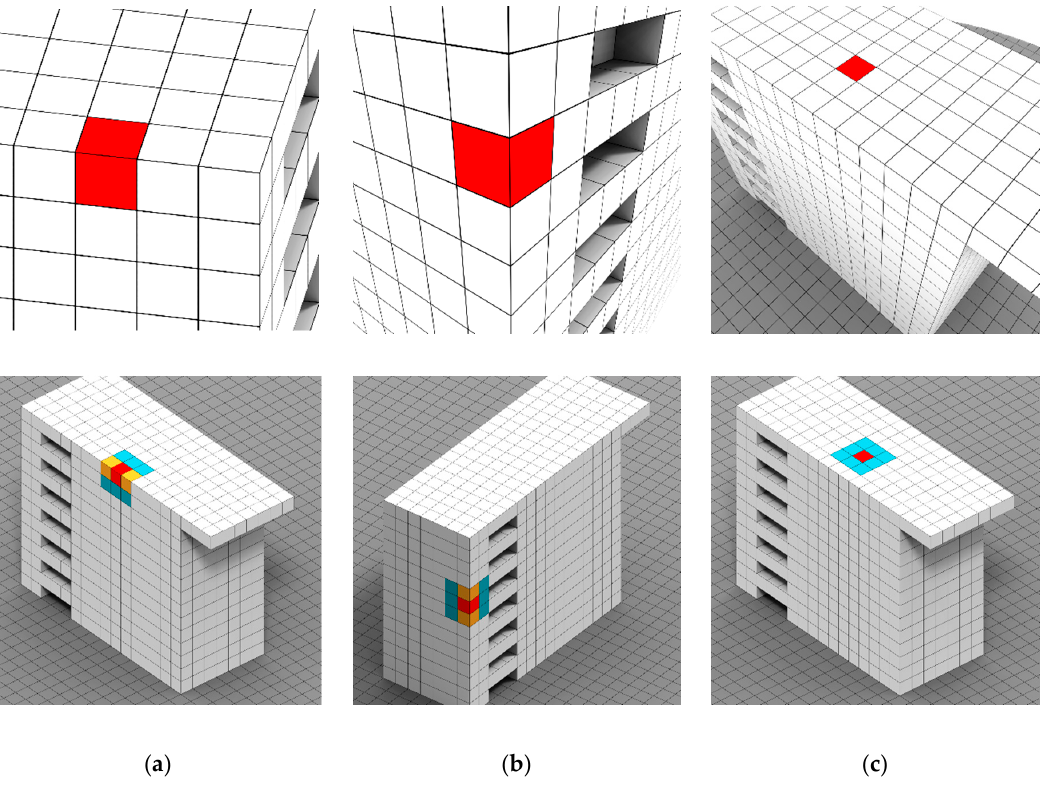
Figure 8. Relationship tagging in the voxel-space. ( a ) represent a mixed relationship M∇ , ( b ) a pure Figure 8: Relationship tagging in the voxel-space. (a) represent a mixed relationship (cid:2279)(cid:2306) , (b) a pure Figure 8: Relationship tagging in the voxel-space. (a) represent a mixed relationship (cid:2279)(cid:2306) , (b) a pure vertical relationship (cid:2288)(cid:2306) , and (c) a pure horizontal relationship (cid:2274)(cid:2306) . vertical relationship V∇ , and ( c ) a pure horizontal relationship H∇ . vertical relationship (cid:2288)(cid:2306) , and (c) a pure horizontal relationship (cid:2274)(cid:2306) .